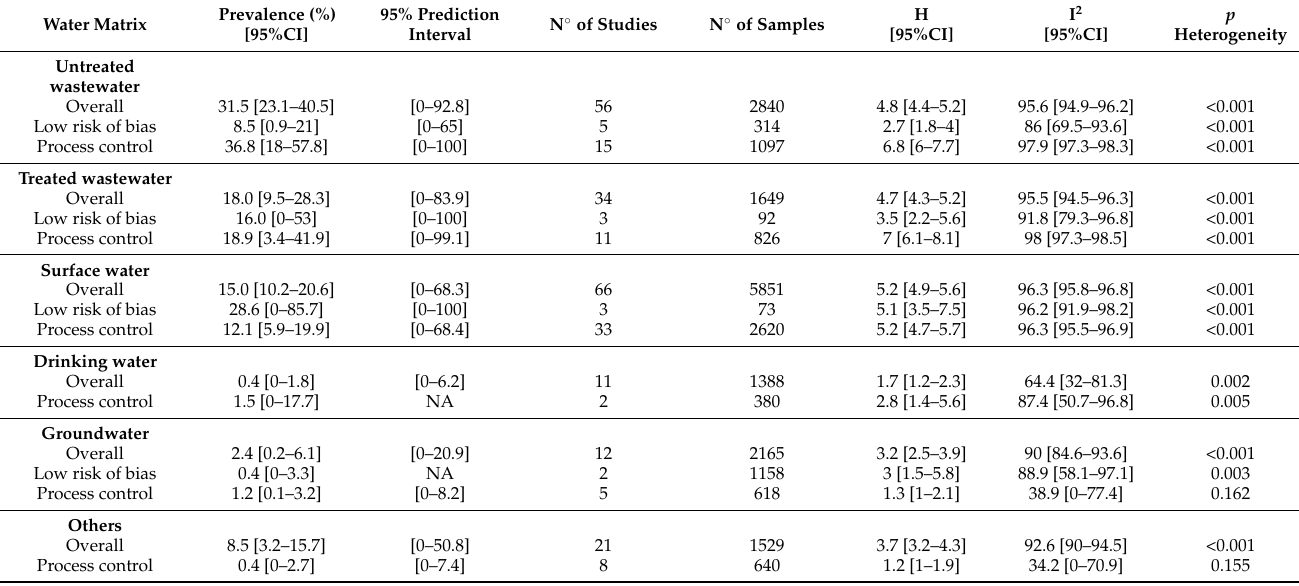
Table 1. Summary of global meta-analysis results for the prevalence of hepatitis A virus in different water matrices divided by risk of bias and by use of process